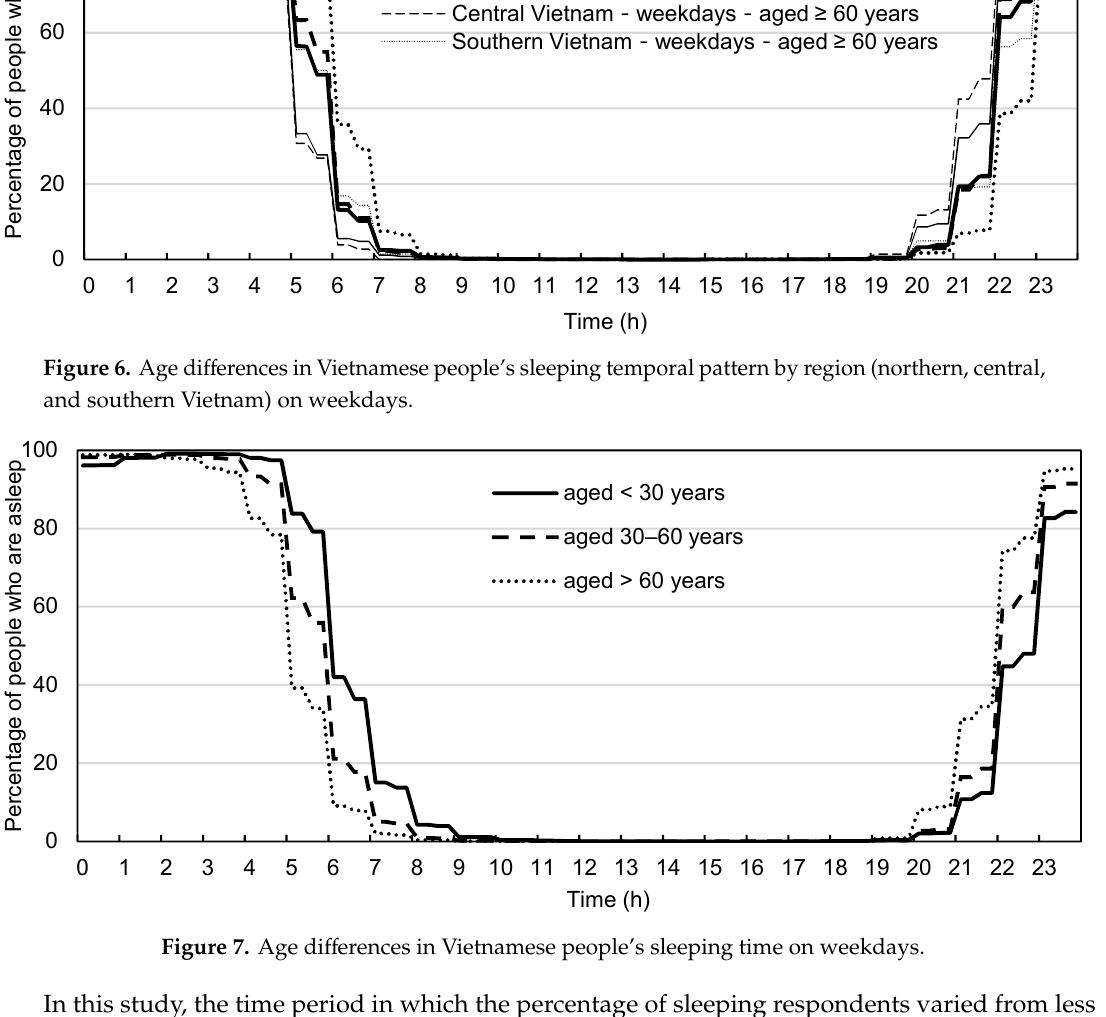
Table 8. Comparison between the least-squares means of go-to-bed time and wake-up time by age, sex, region, and day.